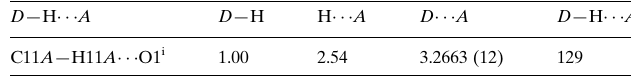
Hydrogen-bond geometry (A˚ , (cid:3)